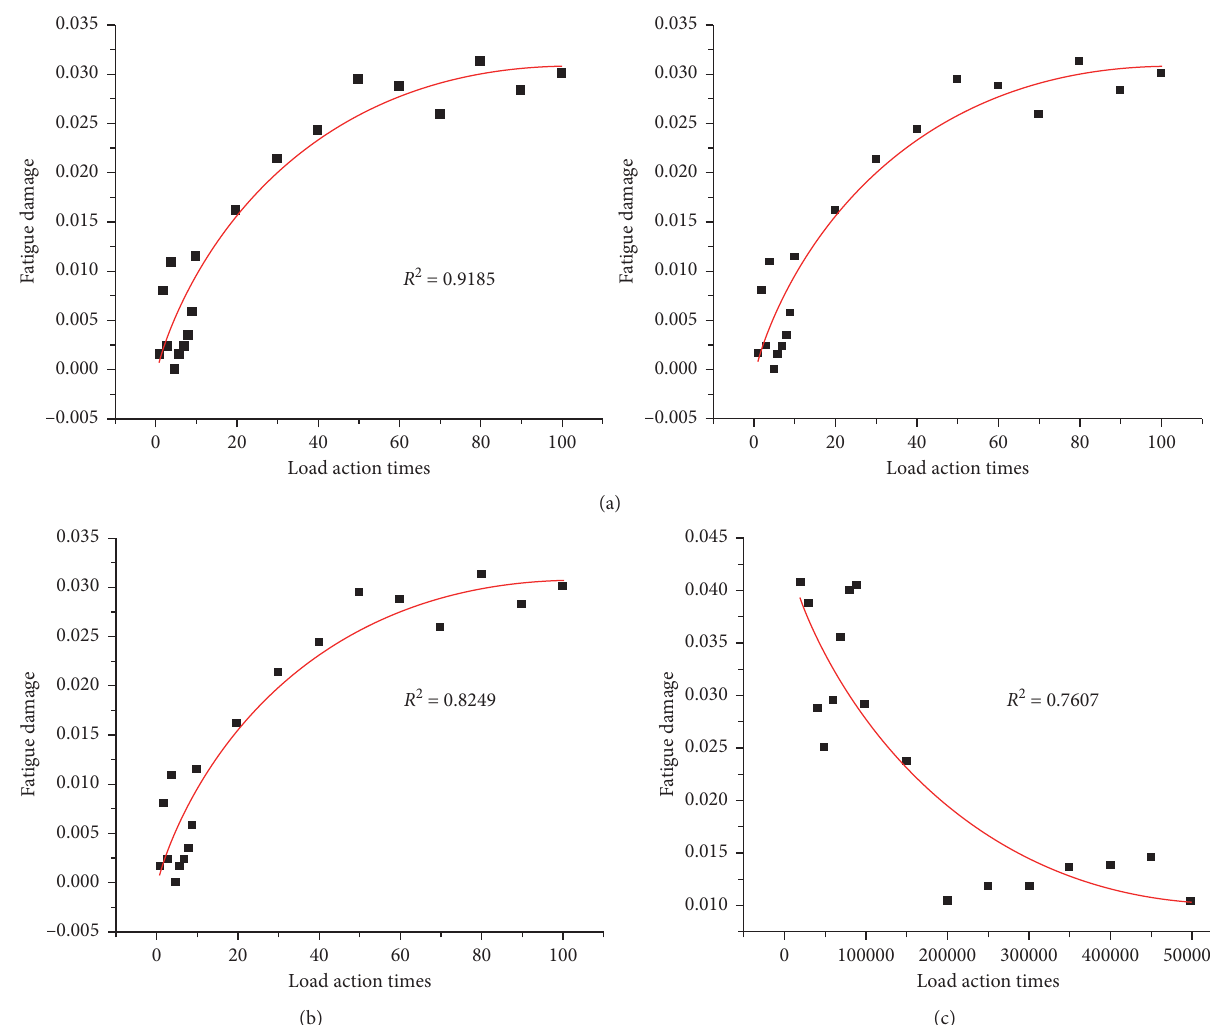
Figure 2: Accumulation of fatigue damage at each stage of 0.3g/cm 3 polymer at a stress ratio of 0.7. (a) The first stage of fatigue damage of 0.3g/cm 3 polymer under 0.7 stress level. (b) The second stage of fatigue damage of 0.3g/cm 3 polymer under 0.7 stress level. (c) The third stage of fatigue damage of 0.3 g/cm 3 polymer under 0.7 stress level.